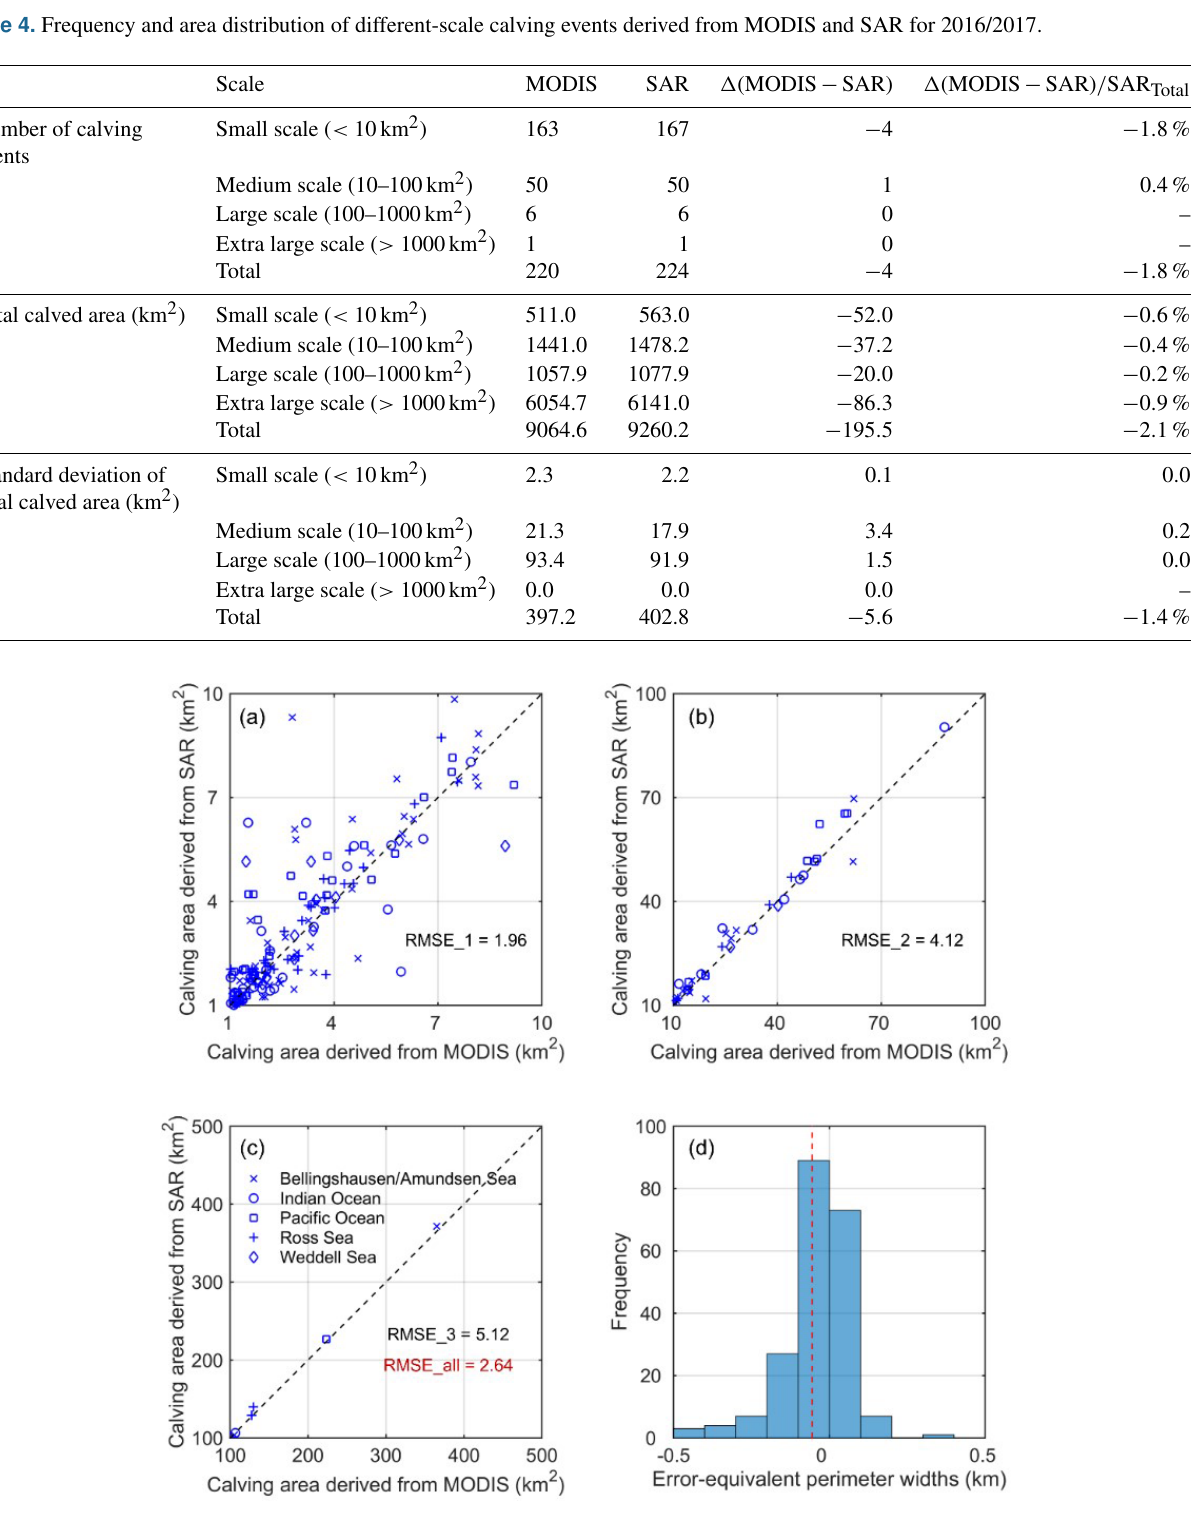
Figure 4. Comparison of areas of individual calving extracted from MODIS and SAR for 2016/2017. Panels (a–c) show the small-scale, medium-scale, and large-scale calving events, respectively. Panel (d) shows the error distribution histogram of error-equivalent perimeter